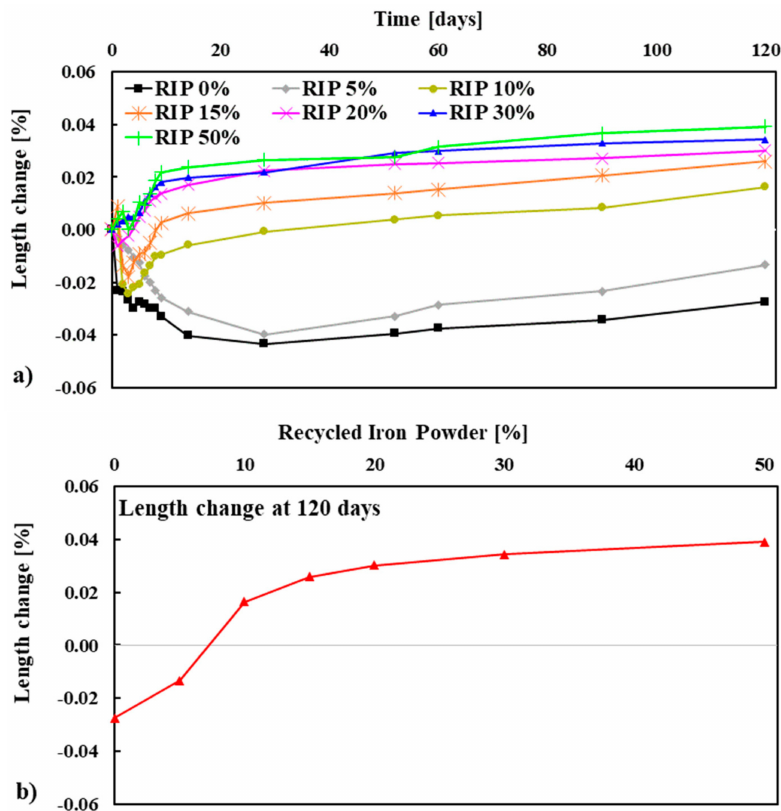
Figure 7. Length change ( a ) and maximum length change measured at 120 days ( b ) of mortar